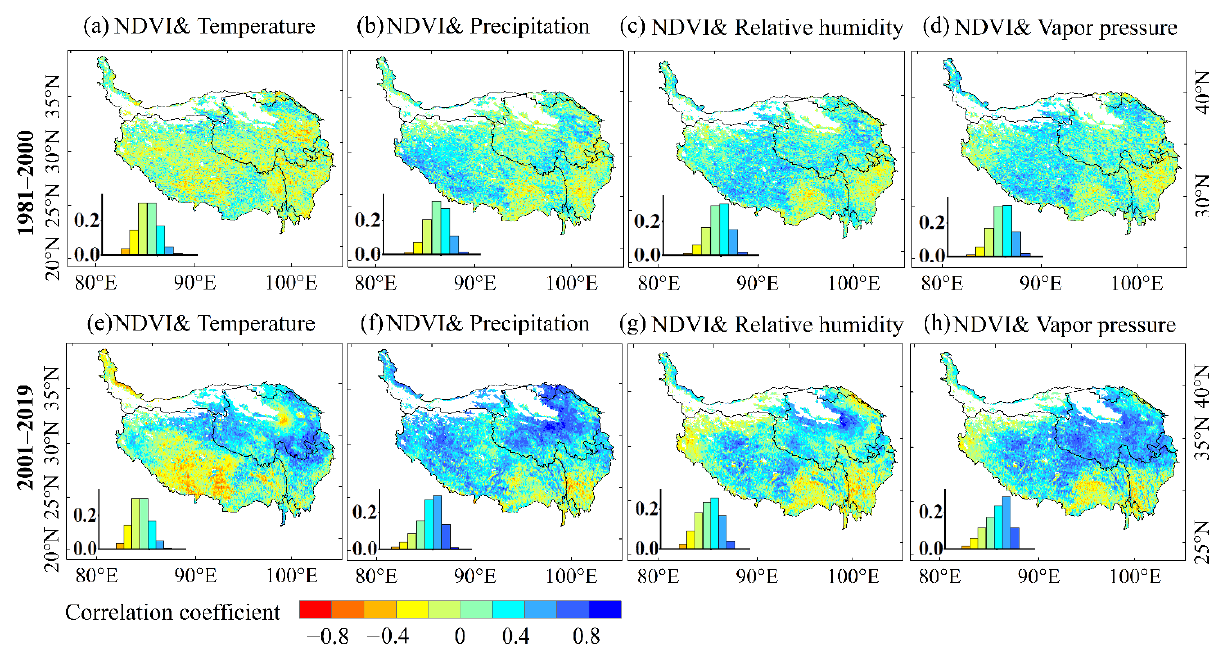
Figure 6. Spatial distributions of correlation coefficient between NDVImax and climatic variables in growing season.